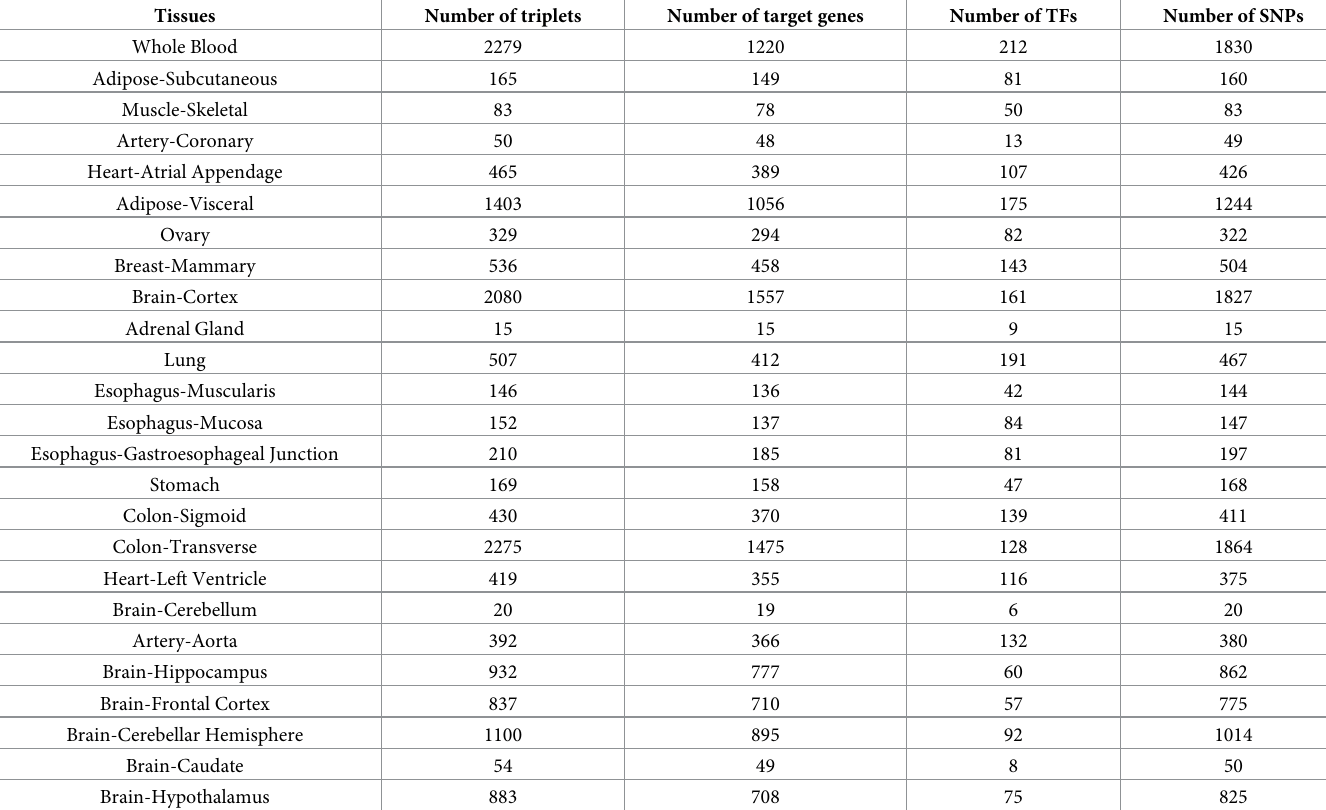
Table 1. The number of detected interaction triplets across 25